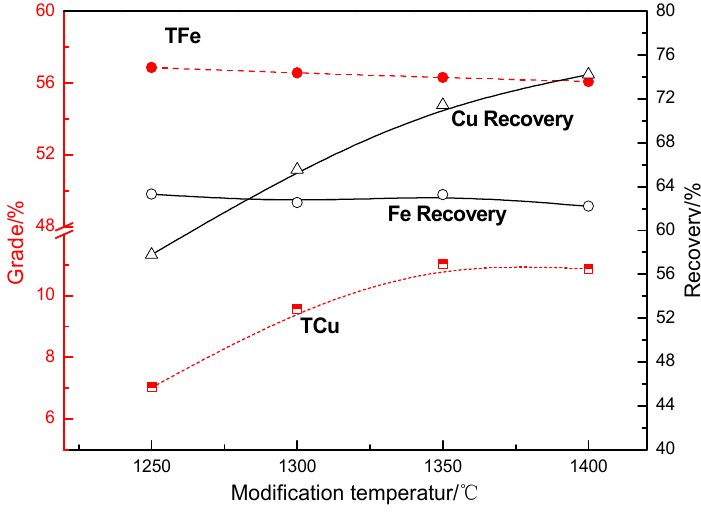
Figure 7. Effects of slag modification temperature on recovering of copper and iron (0.45 of binary basicity, blending with 12% of compound additive, modifying for 120 min and cooling at 1.5 °C/min from 1350 to 900 °C).